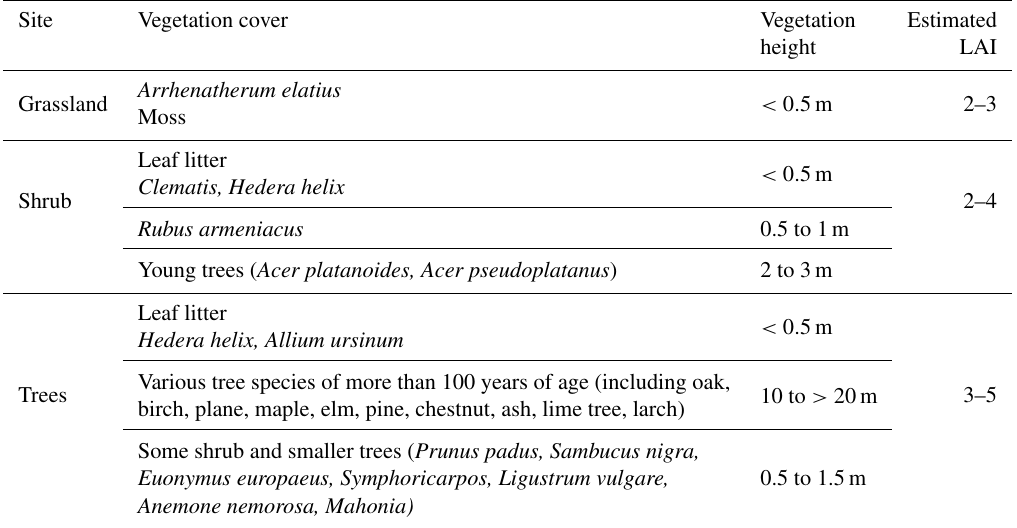
Table 1. Main plant species covering the three sampling plots and their approximate heights and estimated mean leaf area index (LAI) ranges over the study period in the different vegetation